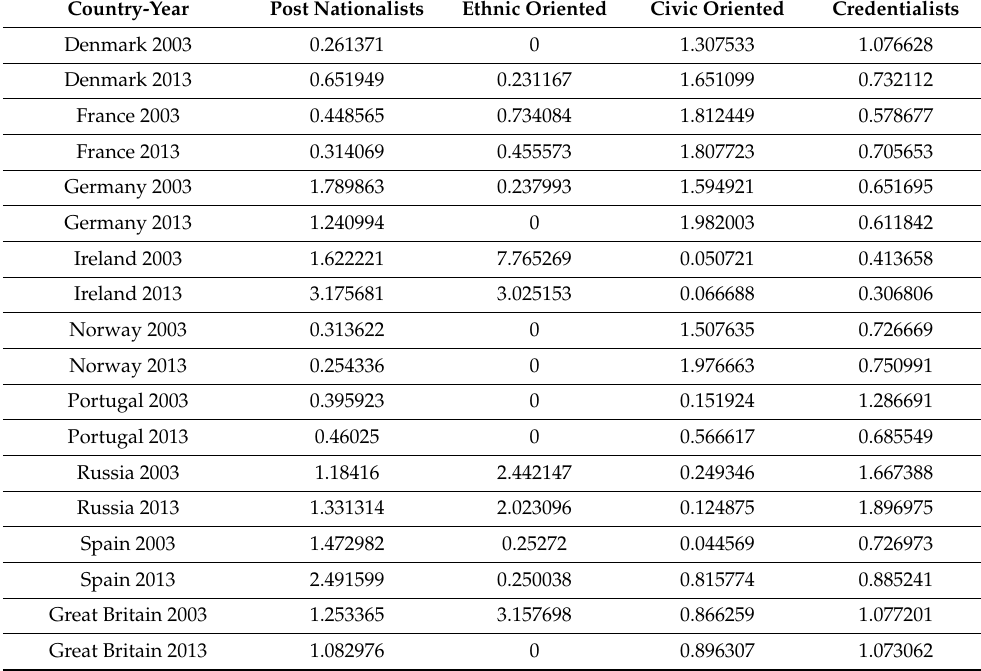
Table 5. Ratios between national identity and country-year, political-orientation-year, and age-year.